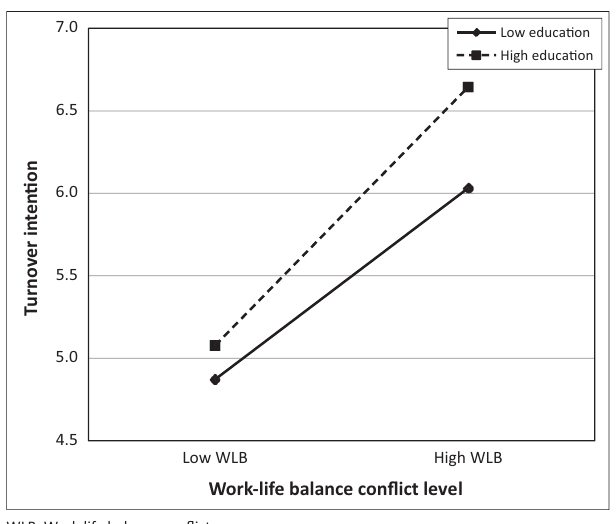
Work-life balance conflict FIGURE 7: Education levels as a moderator on the work-life balance–turnover intention relationship (two-way interaction).